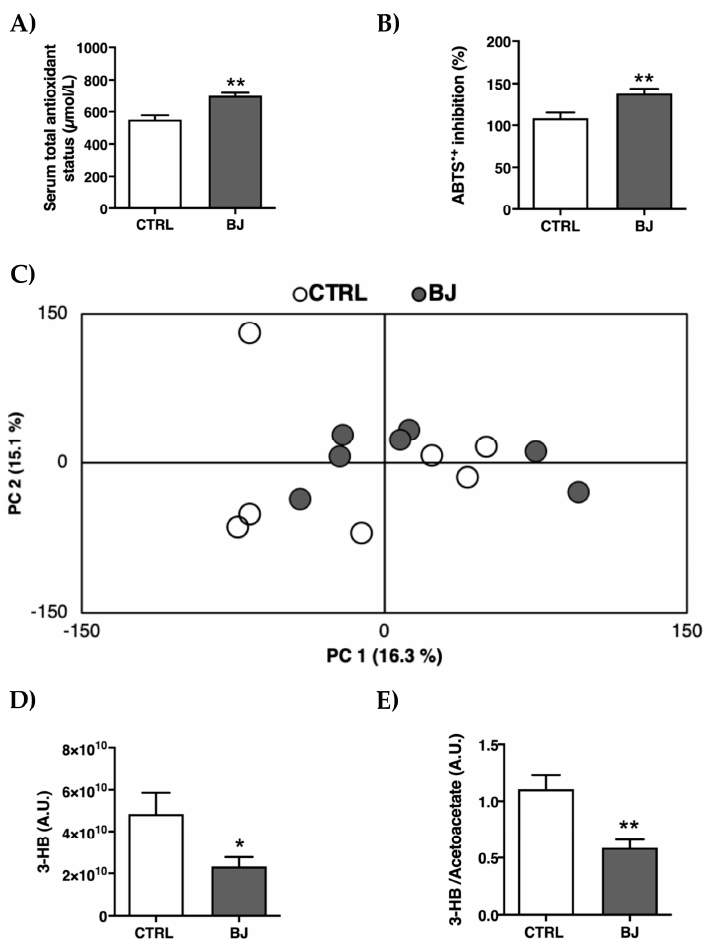
Figure 2. Serum antioxidant capacity evaluated by FRAP ( A ) and ABTS ( B ) assays; principal component analysis (PCA) scores plot obtained by multivariate analysis of 1 H NMR spectra of serum data ( C ); Serum levels of 3-hydroxybutyrate (3-HB) ( D ) and 3-HB / acetoacetate ratio ( E ). Data are presented as mean ± SEM ( n = 6–8 / group); * p < 0.05 and ** p < 0.01 vs. CTRL group.